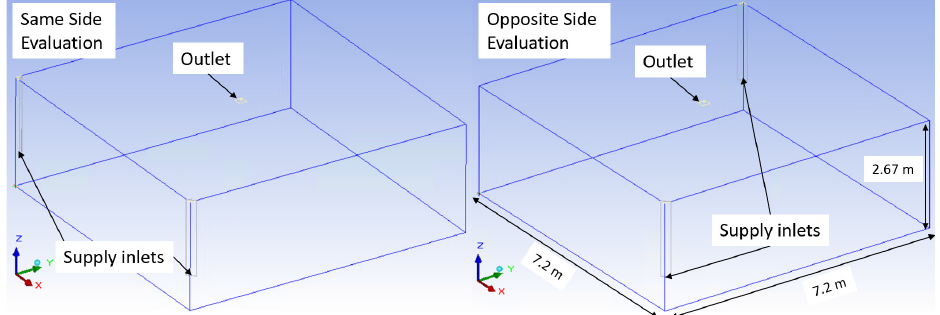
Figure 2. The layout of the measurement positions and their distance to each corner part of the room. picture of the inlet is shown with its